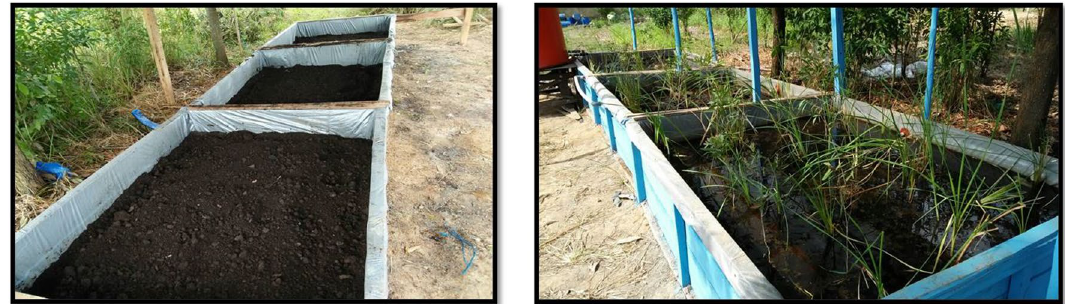
Figure 4. The picture of expremental box (reactor) for laboratory simulation to treat the AMD to change not comply parameter at inlet to be comply at outlet (personal documentation).